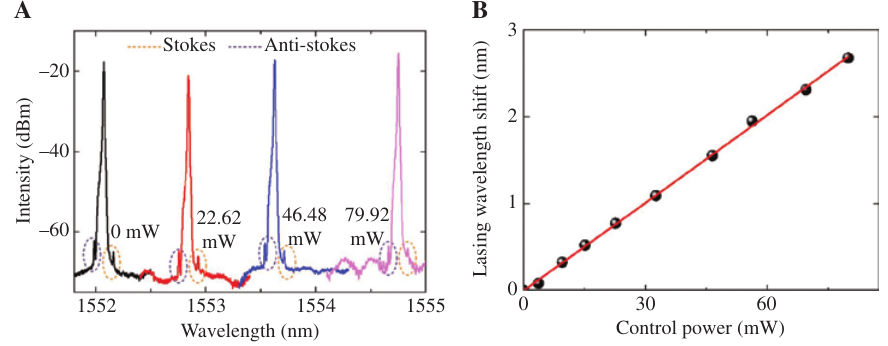
Figure 4: Tuning performance of the Brillouin microlaser. (A) Corresponding Brillouin laser spectra for different control powers. The orange dotted ellipse surrounded peaks represent the Stokes laser, and the purple dotted ellipse surrounded peaks denote the anti-Stokes laser. (B) Lasing wavelength shift as a function of the control power. The red line is linear